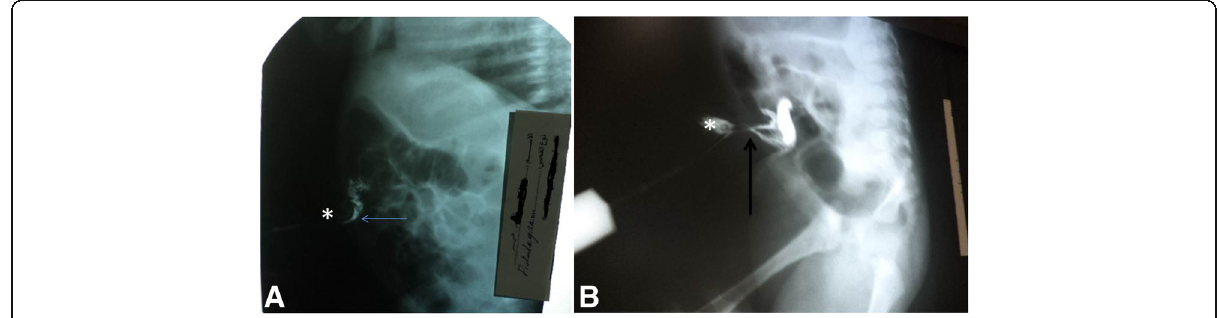
Fig. 8 Vitello-intestinal fistula in two infants. a , b Fistulogram images showing the fistulous tracts (arrows) behind the umbilicus